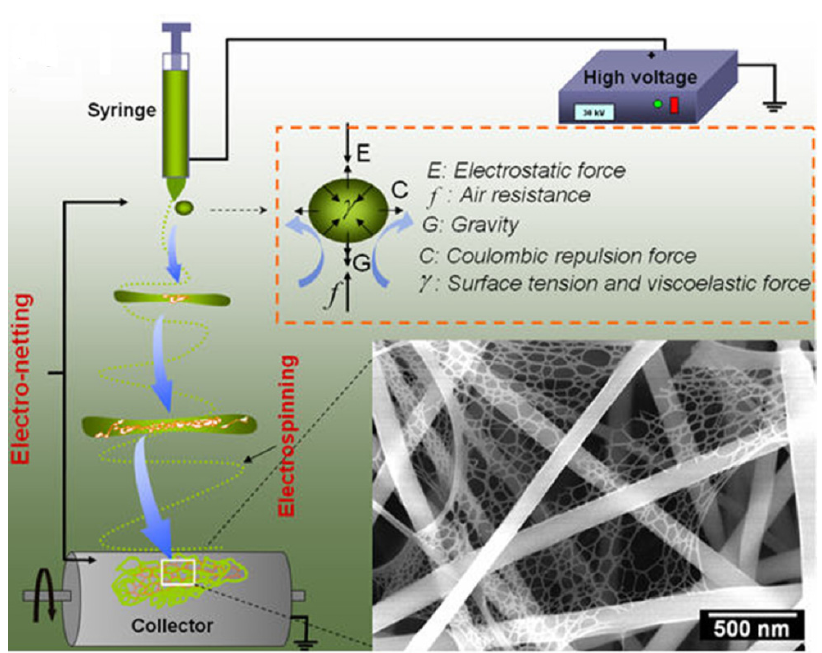
Figure 12. Schematic of possible nanonet formation mechanisms during electrospinning, the forces acting on the droplets, and an SEM image of the fibers and nets formed. (Reprinted with permission from [71]. Copyright 2013 Elsevier.).